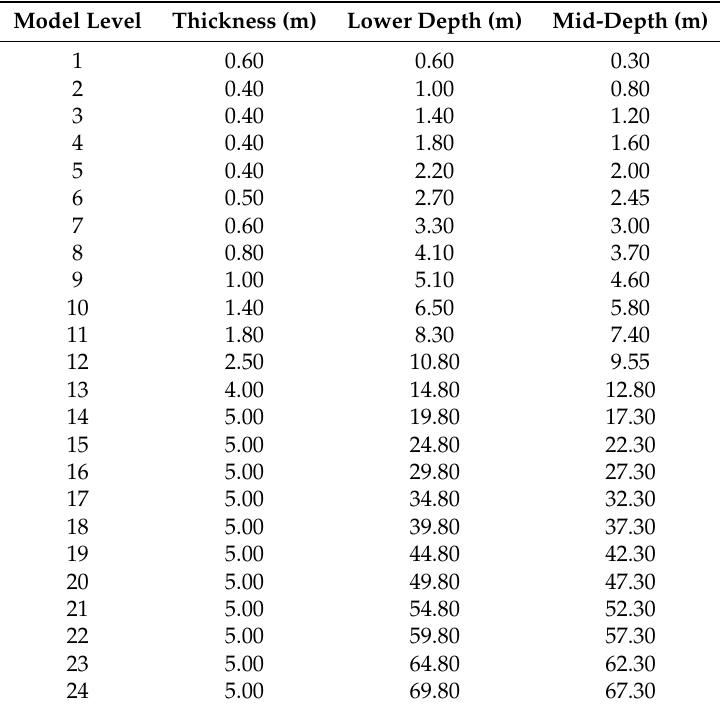
Table 1. EcoPuckBay’s vertical